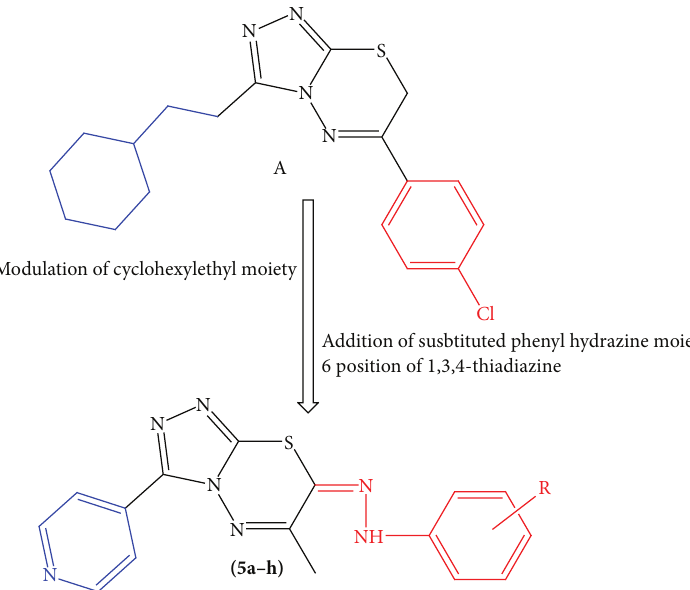
Figure 1: Structure of the lead compound A and new synthesized compounds 5a–h